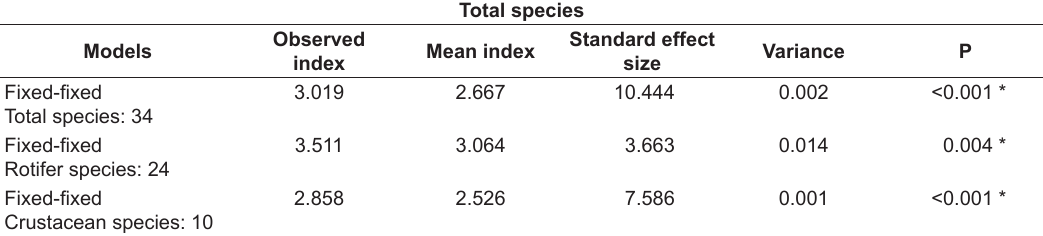
Figure 2. UPGMA based on neighbour-joining method for total species (up), rotifer species (center) and crustacean species Table 4. Results of null model co-occurrence species for total species number, rotifer and crustacean species for studied sites.